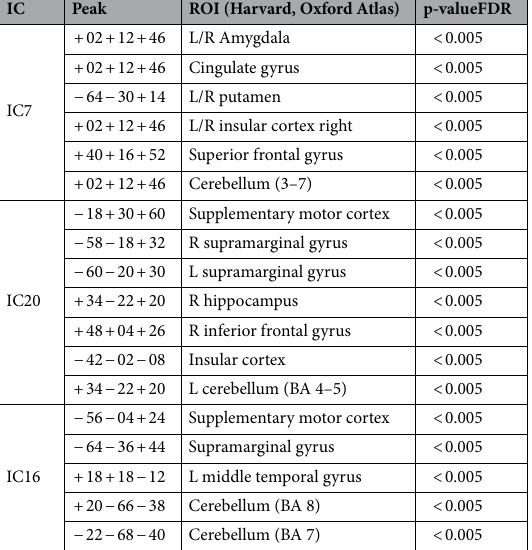
Table 3. Regions identified in the independent component IC7, IC20, and IC16. Clustering indicates the spatial distribution of ROIs at the cortical and subcortical levels. Cluster threshold at p < 0.05 (pFDR corrected) and voxel threshold p < 0.001 (pFDR corrected, two sided). For each cluster we selected the brain regions with the highest covering proportion (%) of Harvard–Oxford Atlas ROI. Peak are reported in MNI coordinates. L left, R right, BA Brodmann